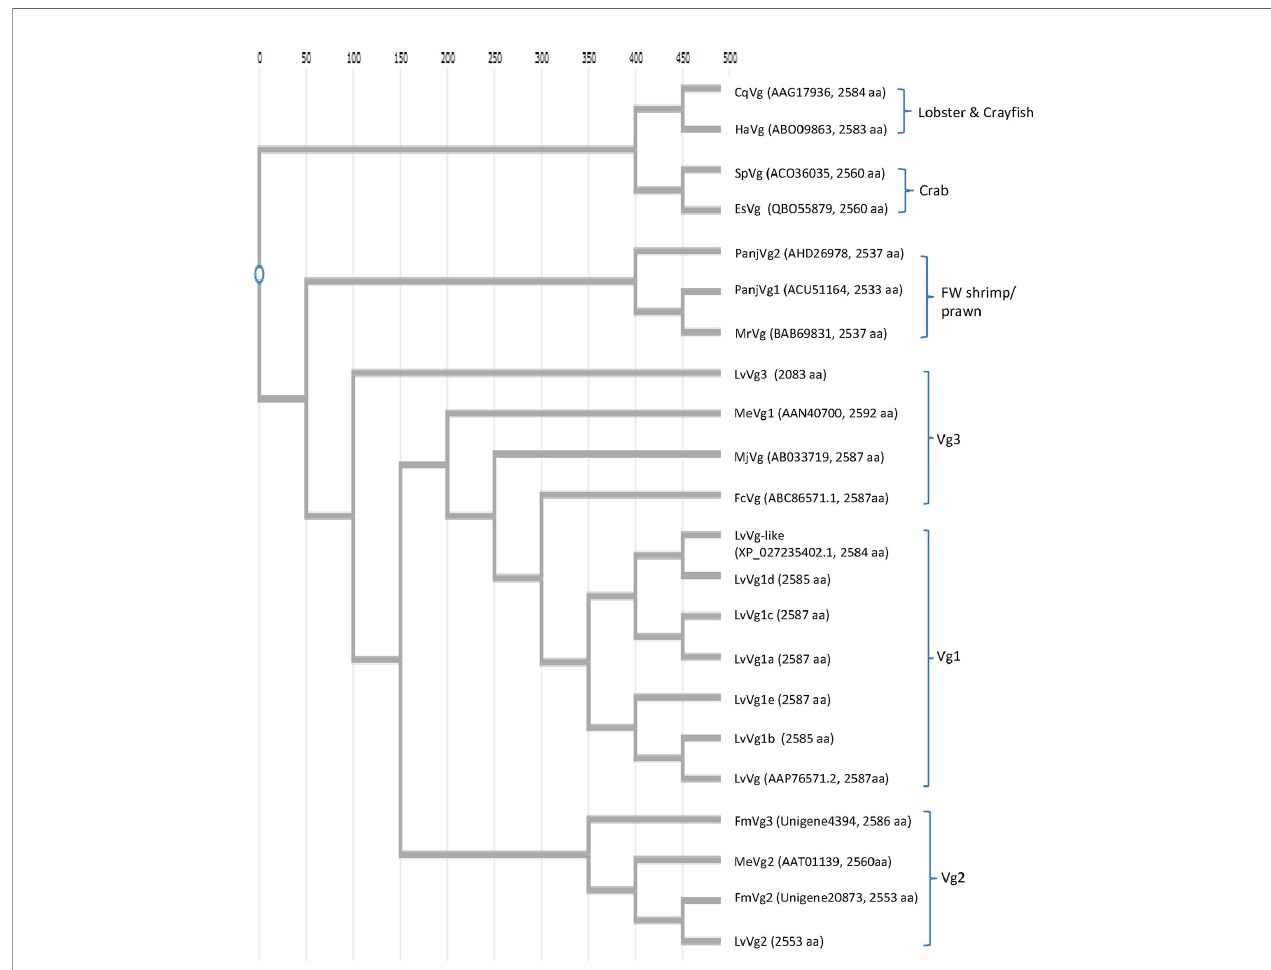
FIGURE 6 | Phylogenetic analysis of selected Vg genes from different decapods. Nucleotide sequences were aligned fi rst with ClustalW software (https://www. genome.jp/tools-bin/clustalw). Phylogenetic tree reconstructions were performed using the function “ build ” of ETE3 v3.1.1 as implemented on the GenomeNet (https://www.genome.jp/tools/ete/). The tree was constructed using fast tree program with slow NNI and MLACC = 3 (24). The GenBank accession numbers and full-length amino acid sizes of the Vg are shown. These include: the red claw cray fi sh Cherax quadricarinatus CqVg (#AAG17936.1), the American lobster Homarus americanus HaVg (ABO09863.1), the mud crab Scylla paramomosian SpVg (ACO36035), and Chinese mitten crab Eriocheir sinensis EsVg (QBO55879.1); the freshwater shrimp Pandalopsis japonica PanjVg1 (AHD26978) and PanjVg2 (ACU511645), the giant river prawn Macrobrachium rosenbergii MrVg (BAB69831); the whiteleg shrimp Litopenaeus vannamei LvVg -like (XP_027235402) and LvVg (AAP76571), the sand shrimp Metapenaeus ensis MeVg1 (AAN40700) and MeVg2 (AAT01139), the kuruma shrimp Marsupenaeus japonicus MjVg (ABC33719), the Chinese shrimp Fenneropenaeus chinensis FcVg (ABC86571), and the banana shrimp Fenneropenaeus merguiensis FmVg3 and FmVg2 (Unigene4394 and Unigene20873 in our unpublished data). Other L. vannamei Vg genes identi fi ed from the current study included LvVg1a-e (CL2883.Contig1-5), LvVg2 (Unigene9553), and LvVg3